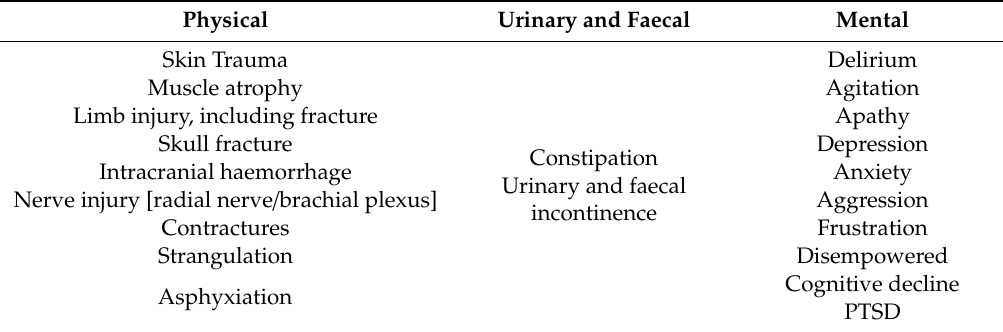
Table 2. Consequences of restraint.